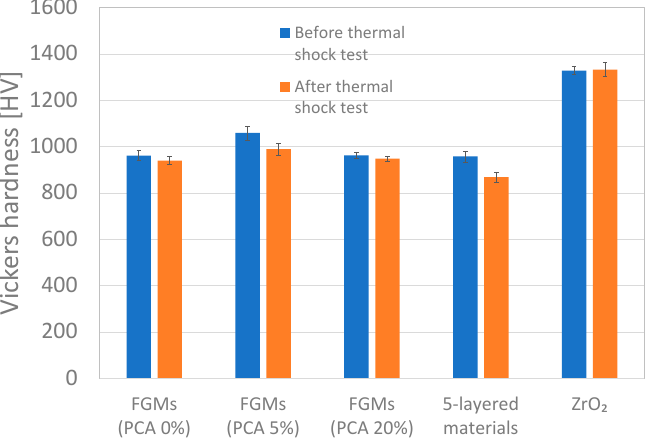
Figure 17. Vickers hardness on ZrO 2 -rich surfaces of the FGMs with PCA (0%, 5% and 20%) and 5-layered materials before and after cyclic thermal shock tests.